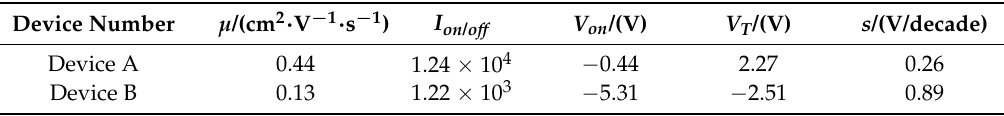
Table 1. Comparison of device properties for device A and